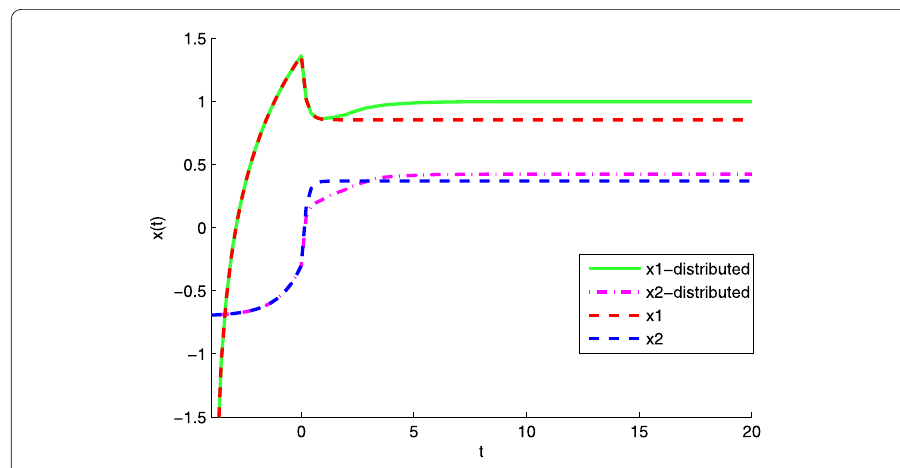
Figure 4 State trajectories of model (46) without discrete delay, or without delay